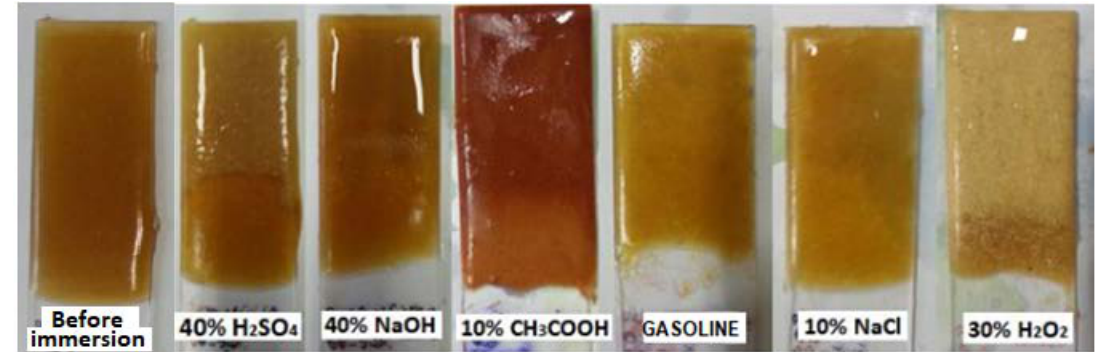
Figure 15. Samples of epoxy composites composed of the RGI filler and the ER3 polymeric matrix after 28 days of exposure to various chemically aggressive environments.